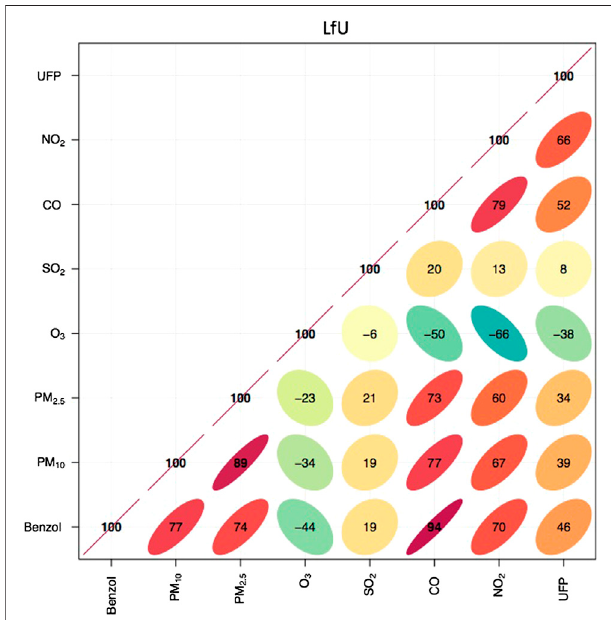
FIGURE 10 | Spearman rank correlation coef fi cients of the hourly UFP number concentrations as well as the legally regulated air pollutants at the LfU measurement site [for a better overview only the decimal values after 0. are